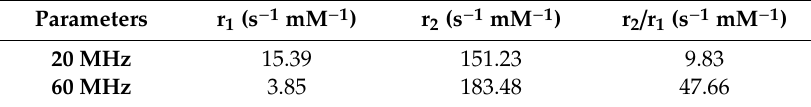
Table 1. The values of MNP-DSPE-PEG relaxivities at 20 and 60 MHz, 37 ◦ C.